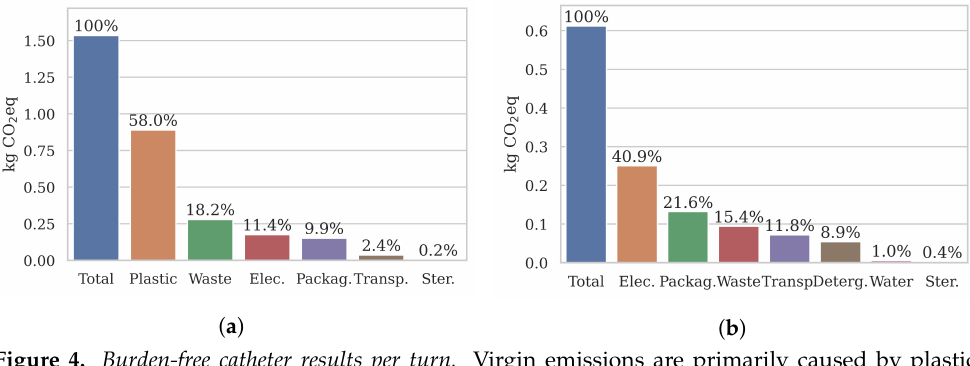
Figure 4. Burden-free catheter results per turn. Virgin emissions are primarily caused by plastic processing and incineration. In contrast, remanufactured emissions are more evenly distribution across categories. ( a ) Virgin catheter emissions E f v . ( b ) Remanufactured catheter emissions E f r